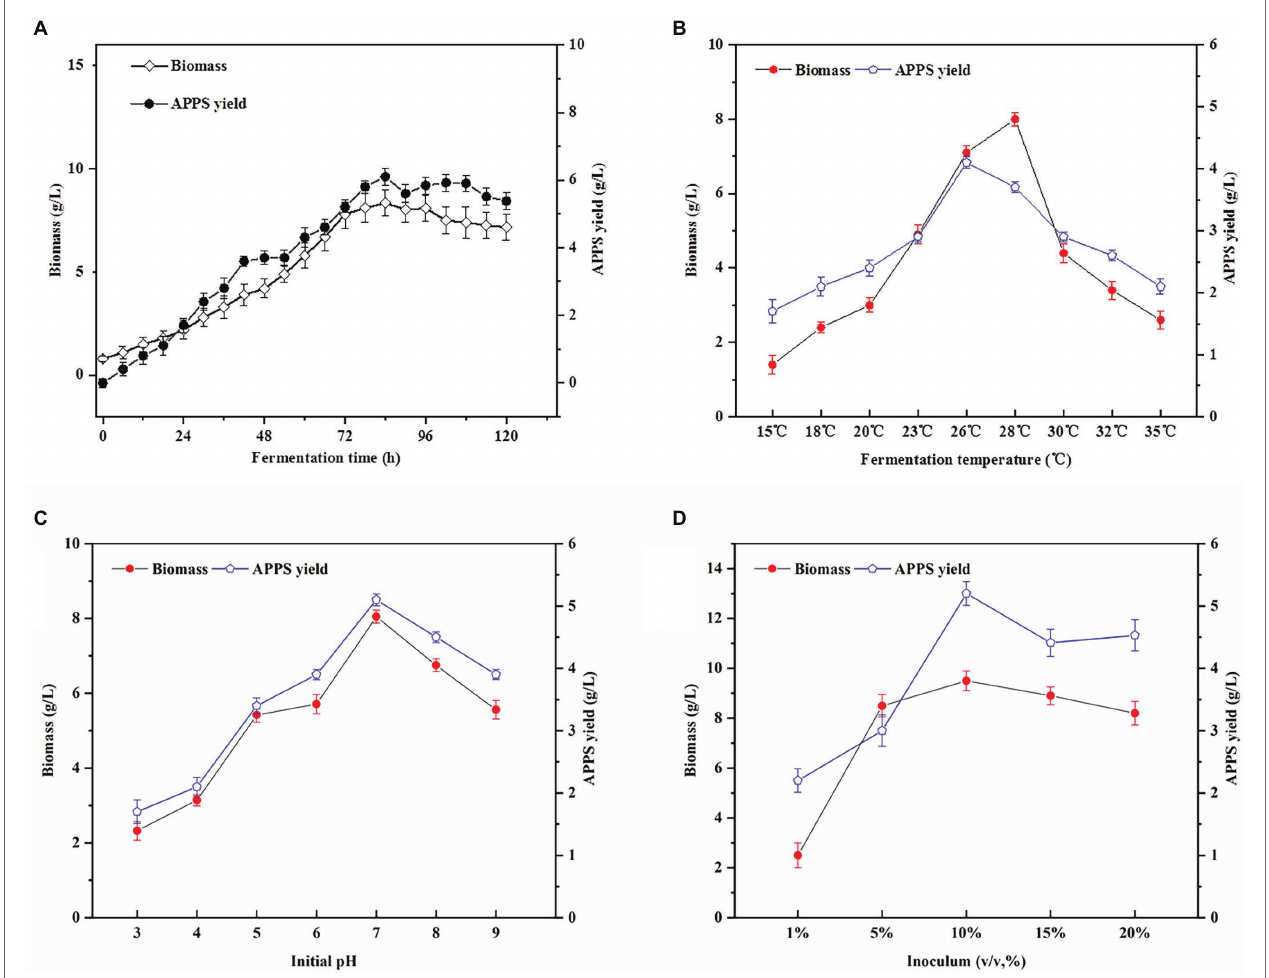
Figure 1 . In Figure 1A , within 96 h after the beginning of fermentation, the biomass and APPS yields increased linearly with fermentation time. Then, the curve entered a brief plateau, probably due to depletion of carbon sources. The yield of APPS was the highest (6.1 ± .247 g/L), which was significantly higher than that of 24 h (1.7 ± .21 g/L) and 48 h (3.7 ± .189 g/L; p < .05). As a result, 96 h is the best end time of fermentation. Temperature is one of the main conditions affecting the growth of microorganisms, and each strain has its own optimal growth temperature. As presented in Figure 1B , from 15 to 26 ° C, the biomass of AP–10 increases significantly with temperature from (1.4 ± .27 g/L) to (7.1 ± .175 g/L; p < .05), reaching its maximum at 28 ° C. APPS production increases dramatically when the temperature increases from 23 to 26 ° C, and decreases